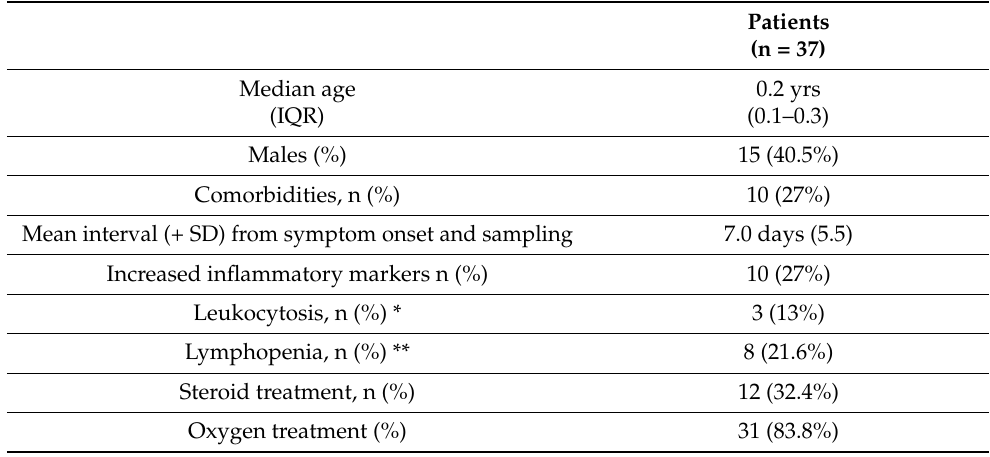
Table 2. Demographics and clinical characteristics of children with acute RSV bronchiolitis. n : number; %: percentage; IQR: interquartile range, expressed as 25 and 75 quartile values; yrs: years; SD: standard deviation. Values upper * or below ** normal limit according to age-related cutoffs.